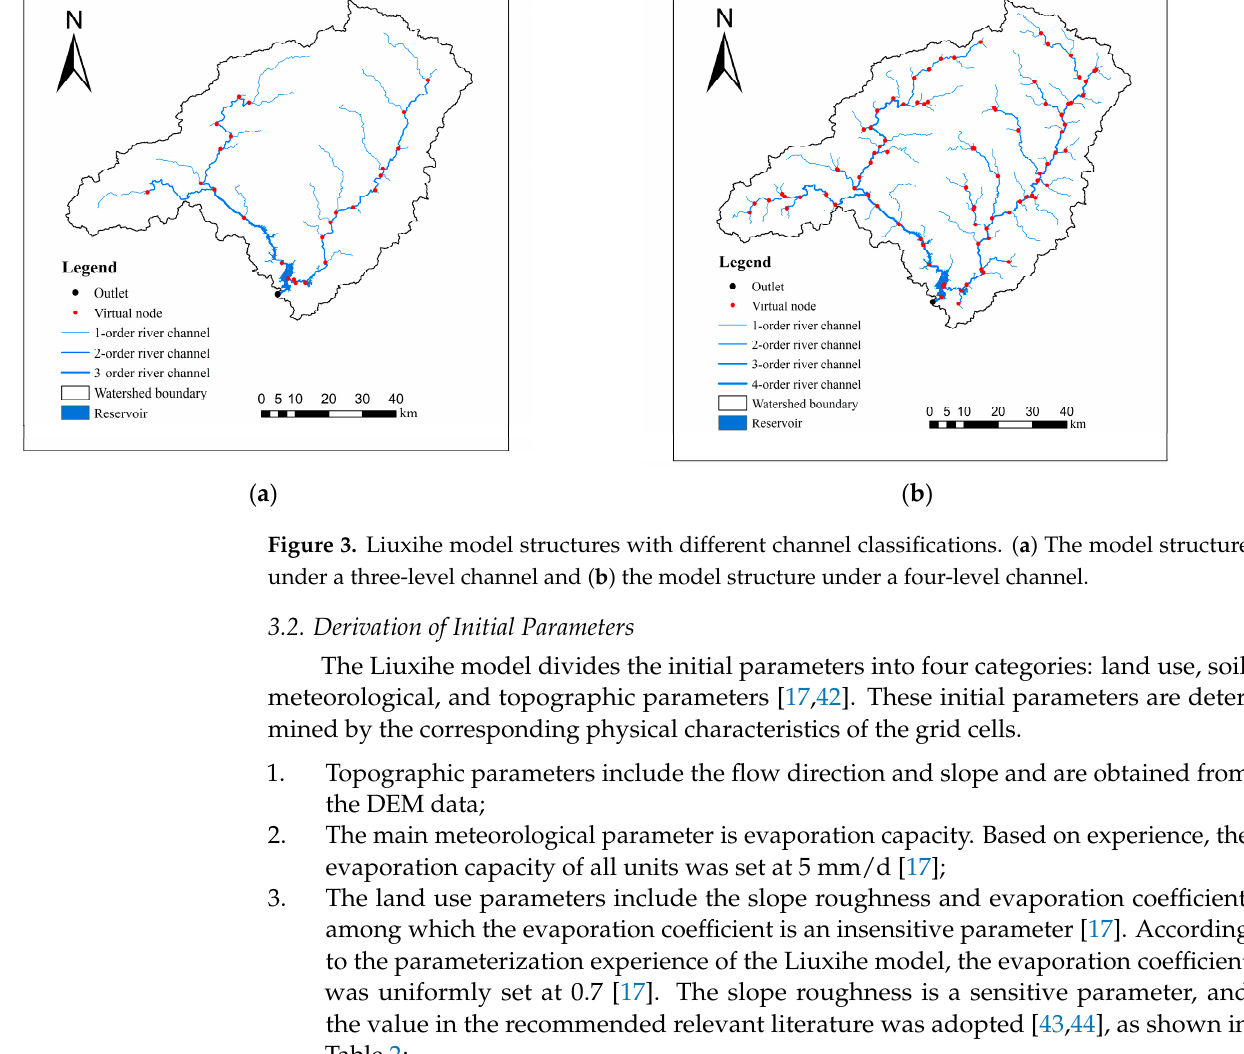
Table 2. Land use parameters. Land Use Type Evaporation Coefficient Slope Roughness Coefficient Evergreen needle-leaf forest Evergreen broadleaf